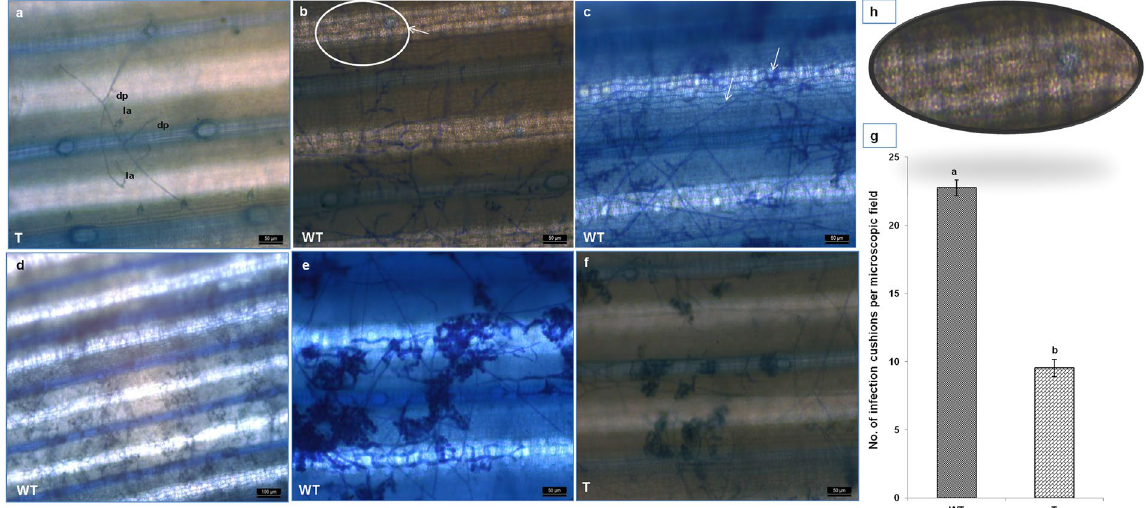
Figure 8. Disease development on transgenic HD-RNAi and control rice plants. ( a ) Hyphae developing side branches which either directly penetrate (dp) or develop into infection structures like lobate appressorium (la); ( b ) Hyphae showing zigzag pattern of growth inside the cells; ( c ) Hyphae invading host tissues via the epidermal cells and stomata; ( d ) Hyphae initiating infection cushion at the site of lesion 24 hpi in non-transgenic controls; ( e ) Densely formed Infection cushions leading to lesion development and necrosis of the cells in non-transgenic control ( f ) and transgenic HD-RNAi rice lines 48 hpi; ( g ) Number of infection cushions in transgenic plants and non-transgenic controls 48 hpi. ( h ) An enlarged section of panel b; WT = Non transgenic plants; T = Transgenic plants. Scale bar: 100 µ m in panel ( d) and 50 µ m in rest of the